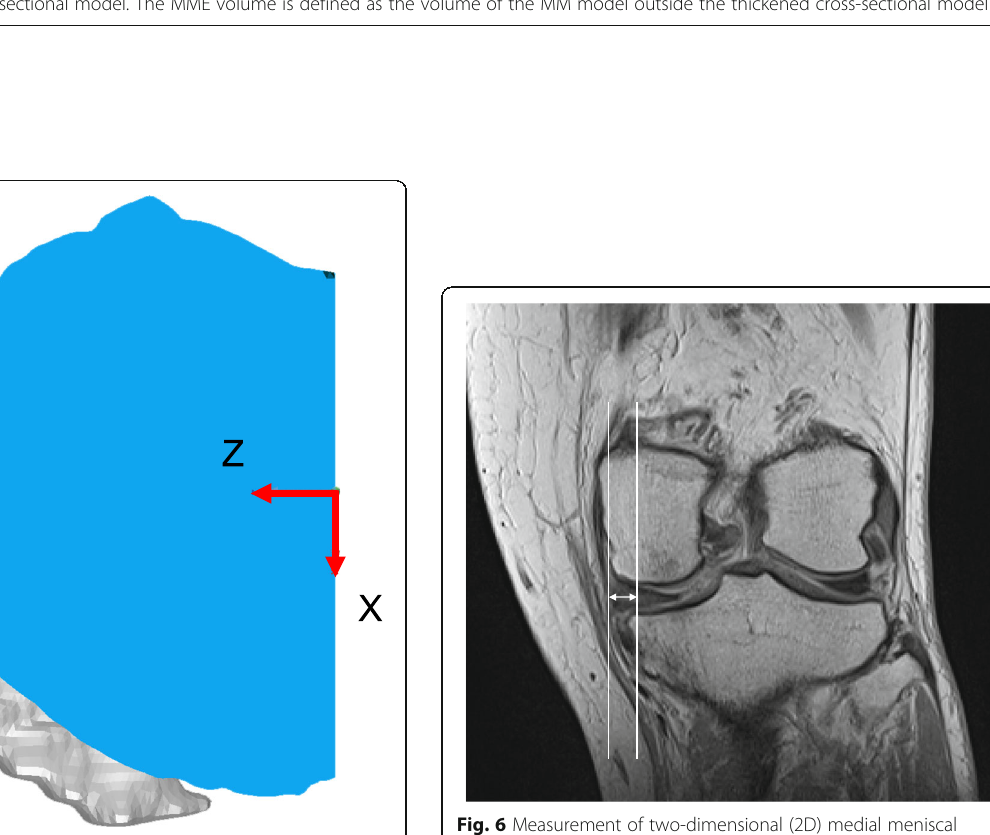
Fig. 5 Width of the medial meniscal extrusion (MME) model. The MME model (gray) and the thickened cross-sectional model are shown from the axial view. The MME width is the distance from the outer edge of the thickened model to the outer edge of the medial meniscus model through the Z-axis